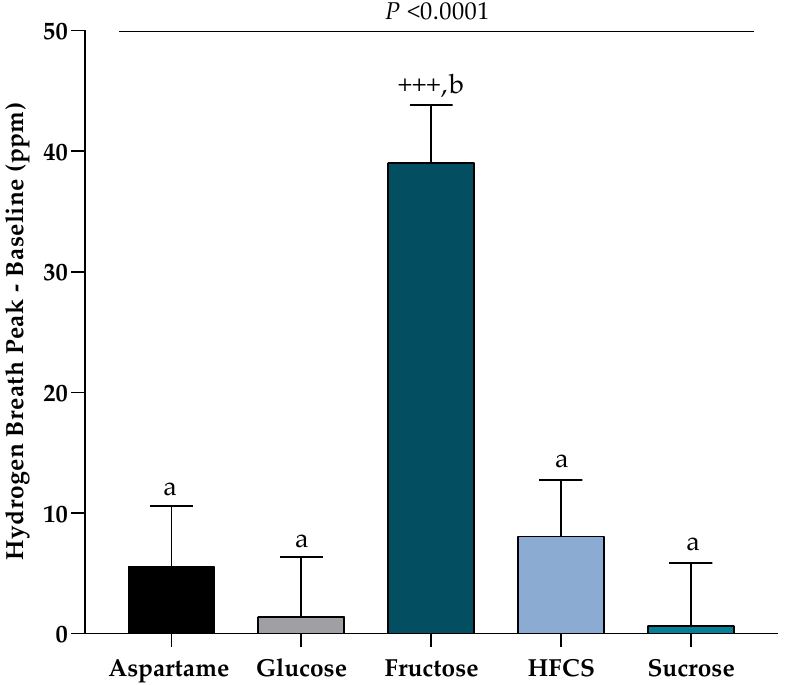
Figure 5. Hydrogen breath after consuming SB: The change in peak hydrogen breath – 0-h value in subjects consuming glucose-, fructose-, high fructose corn syrup (HFCS)-, sucrose-, or aspartame-SB for 2 weeks. p < 0.0001 effect of SB, Kruskal – Wallis test; +++ p < 0.001, Wilcoxon matched-pairs signed rank test; a different from b, Mann – Whitney unpaired tests for each SB versus fructose.